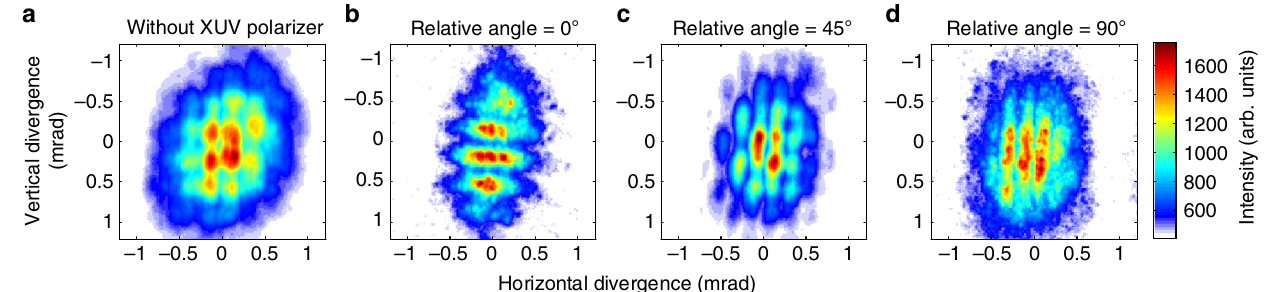
Fig. 3 Reconstructed two-dimensional beam intensity pro fi les of the 25th harmonic beam. The spectrally resolved 2D pro fi le of generated XUV beams can be reconstructed by translating the spectrometer while recording the spectrogram. a Measured beam pro fi le without going through the XUV polarizer. b – d Projected intensity pro fi les for different linear bases. By changing the relative angle b 0°, c 45°, d 90° between the vector beam generator and the XUV polarizer, we measure the intensity distribution of 25th harmonic beam after going through the XUV polarizer. Driven by the designed vector fundamental beam, the generated XUV radiation consists of both s-polarized and p-polarized components shown in b , d . The intensity does not vanish at bright spots, while changing the relative angle between the polarizer and polarization of the beam. c When the relative angle is set to 45°, modulation appears in both vertical and horizontal directions